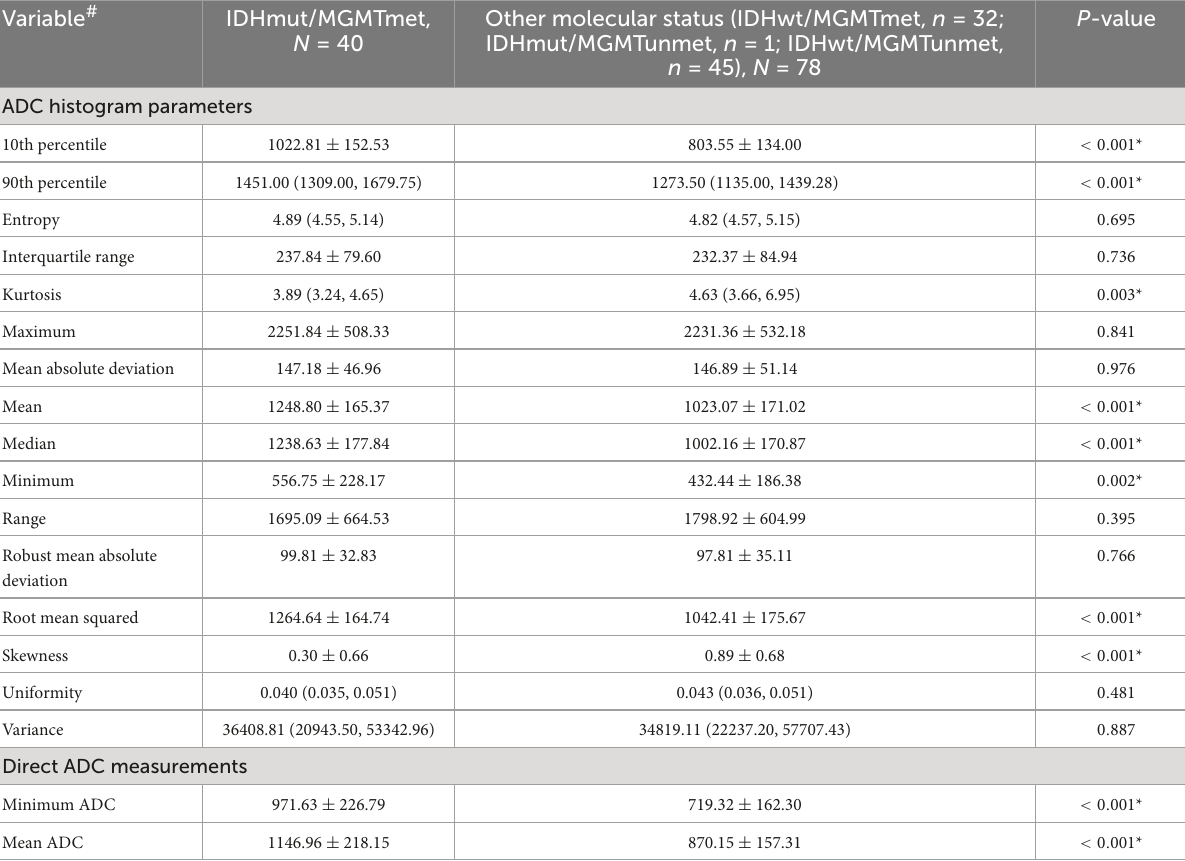
TABLE 2 Comparison of ADC histogram parameters and minimum ADC and mean ADC between IDHmut/MGMTmet and the other glioma group. Variable